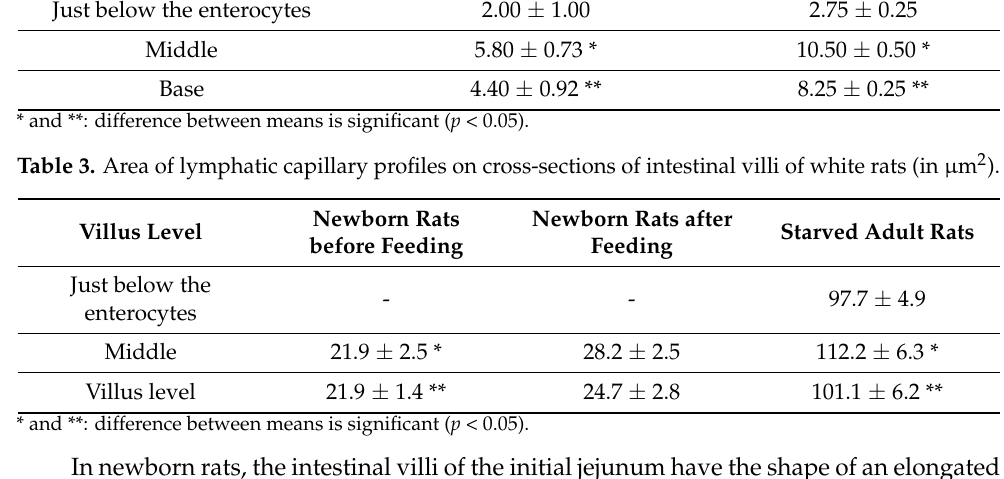
Table 2. Number of blood capillaries on cross-sections of different levels of intestinal villi of white rats. Villus Level Newborn Rats before Feeding Starved Adult Rats Just below the enterocytes 2.00 ± 1.00 Middle